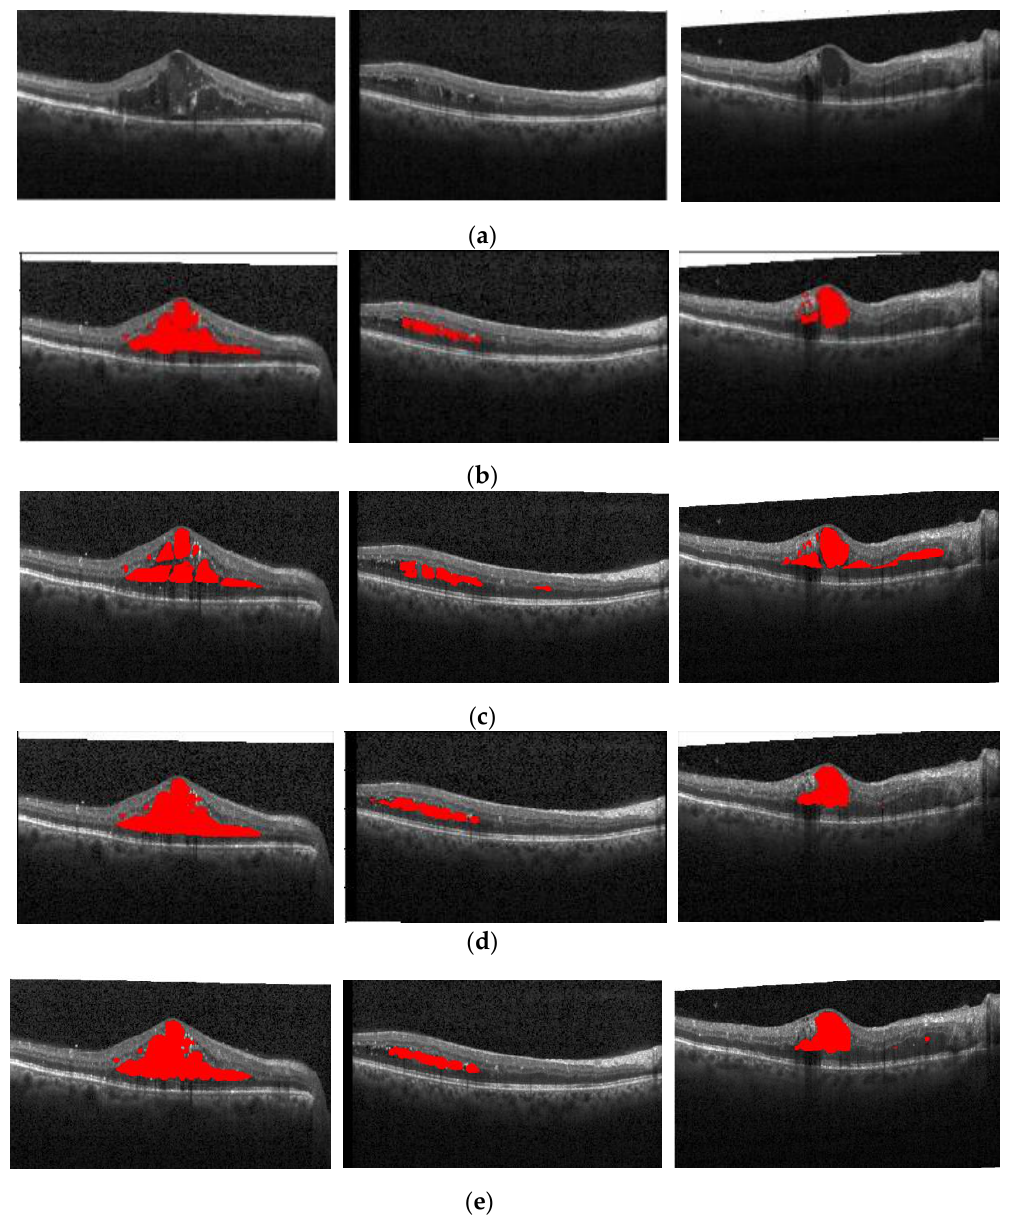
Figure 10. The segmentation results: ( a ) original image; ( b ) expert 1 annotations; ( c ) expert 2 annotations; ( d ) ReLayNet predictions; ( e ) proposed method predictions.